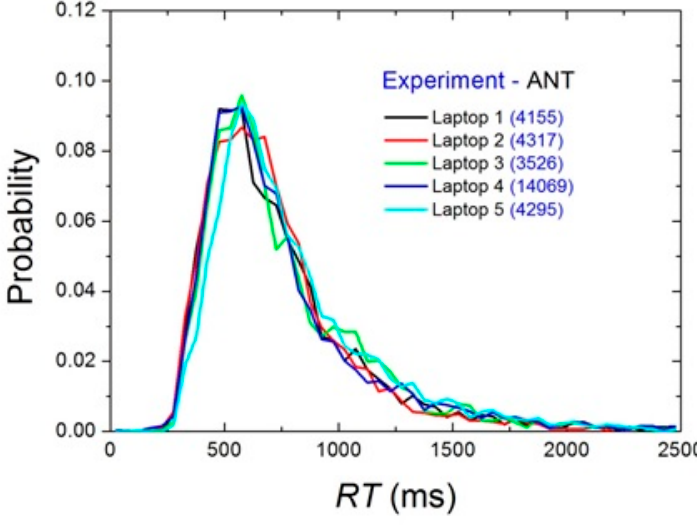
Figure 3. Comparison of the outputs from the different laptop computers used in the experiments.